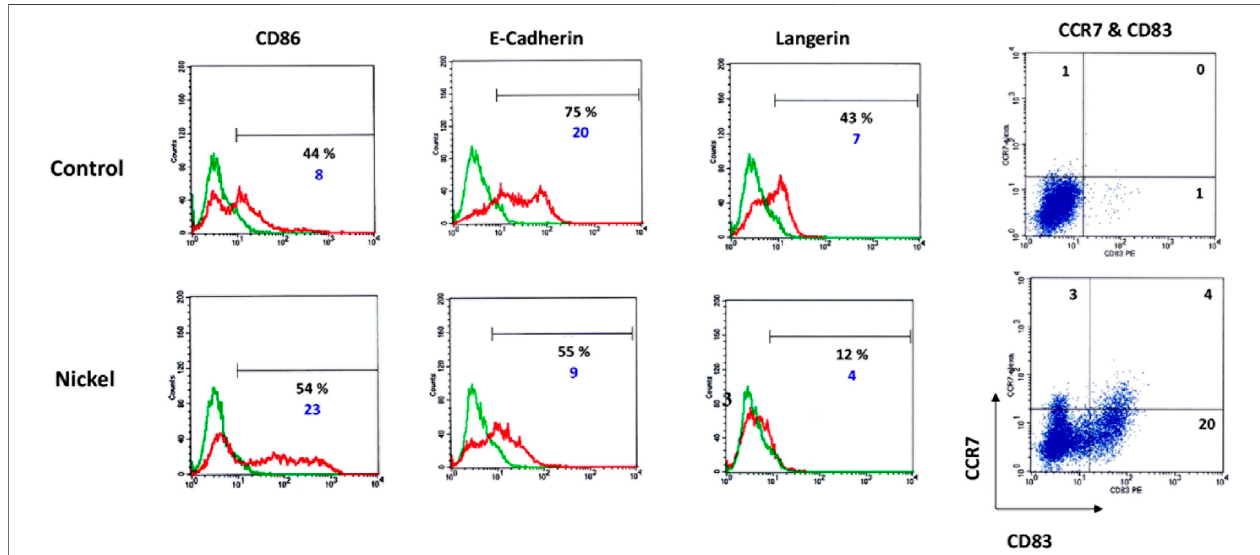
FIGURE2| DCs were generated byculturingCD34 + HPC from cord blood inthe presence ofGM-CSF, TNF- α , and Flt-3Lfor 7 days. Cellswerethen washed and stimulatedornot(control)byNiSO4(500 μ M)for24 hbeforebeinganalyzedby fl owcytometryfortheexpressionofCD86,E-Cadherin,Langerin.Numbersrepresentthe % of positive cells (black number) and cMFI (blue number), which is the ratio between the total MFI obtained using the speci fi c antibody (green lines) to the total MFI obtainedusingacontrol fl uorescentantibodyofthesameisotype(redlines).ForCD83andCCR7,two-dimensionalplotsshowthesurfaceexpressionpro fi leofDC for CD83 and CCR7 or control antibodies. Quadrant position was determined using control Abs for each condition of stimulation. Numbers in each quadrant represent cell percentages.